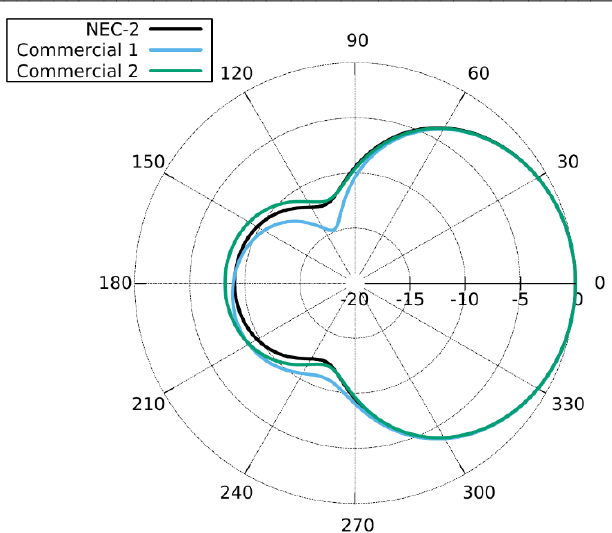
Fig. 9. Normalised radiation pattern of the analysed three-element Yagi in the H-plane. Black line: nec2c; Blue line: commercial code 1; Green line: commercial code 2.